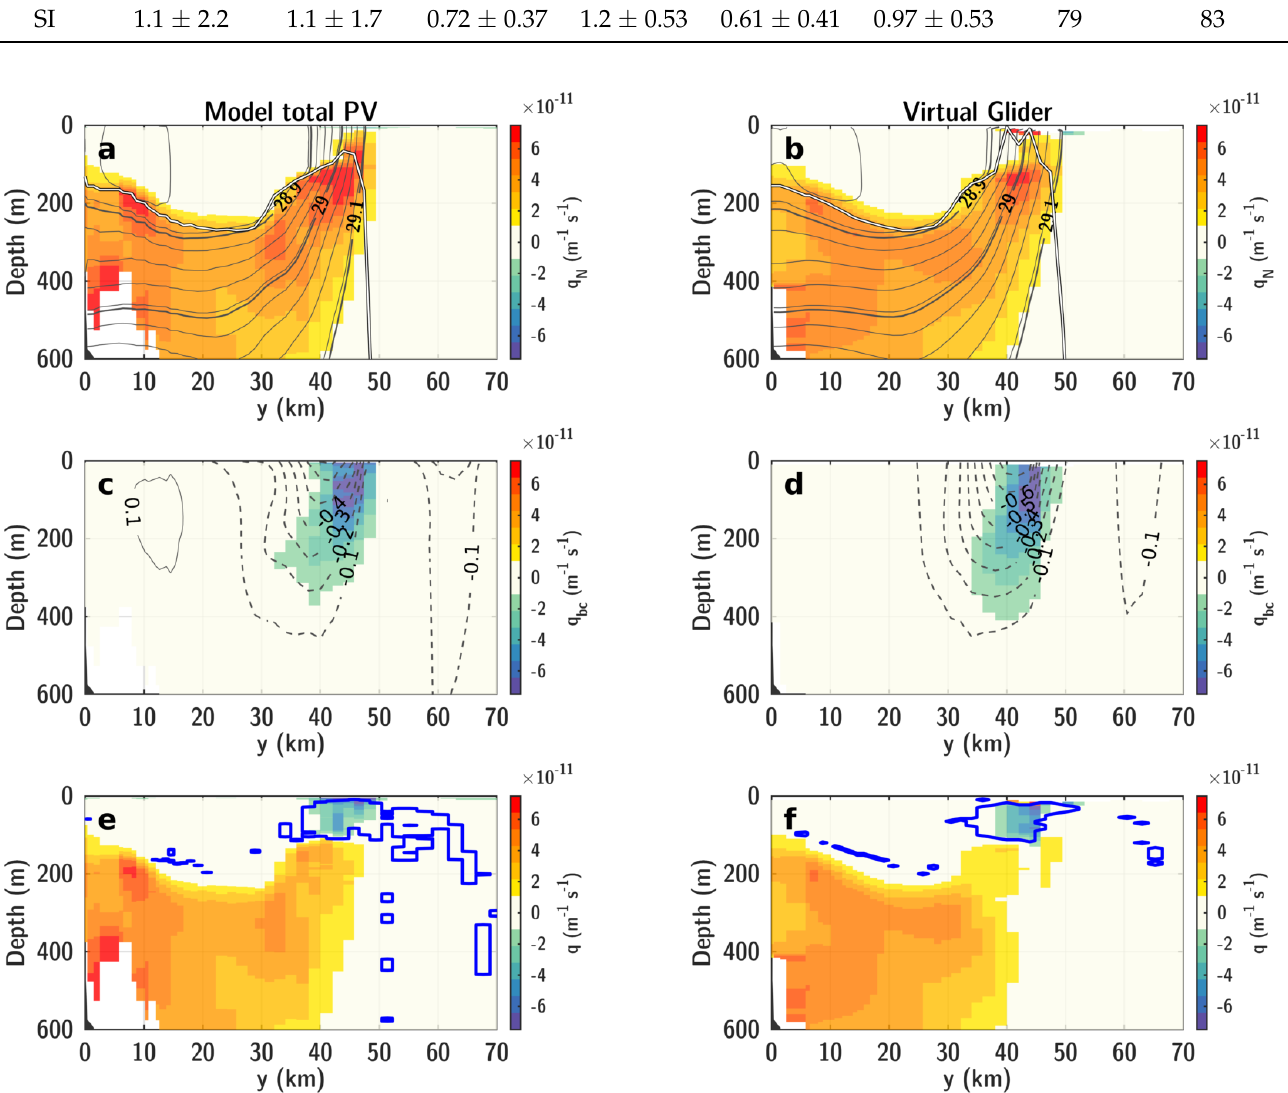
Figure 3. ( a ) Stratification term of PV ( q N ) from model outputs interpolated along a glider trajectory crossing the NC front during a down-front wind event. ( b ) glider-like reconstruction of q N from virtual glider in the model. The white line in ( a , b ) shows the MLD. ( c , d ) Same as ( a , b ) but for the baroclinic PV term, q bc . ( g , h ) Same as ( a , b ) for the total PV, q = q N + q bc . The blue contours represent regions subjective to SI according to the balanced Richardson number (see Section